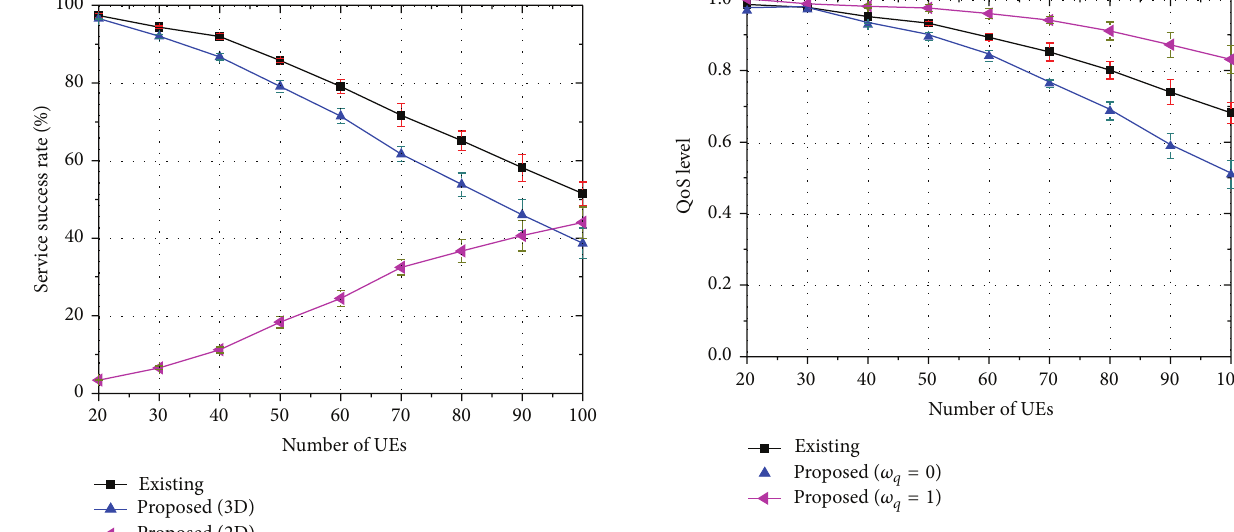
Figure 10: QoS level of 8-viewpoint 3D A/V traffic ( 𝛽 = 0.45 ). proposed strategy outperforms that of the existing